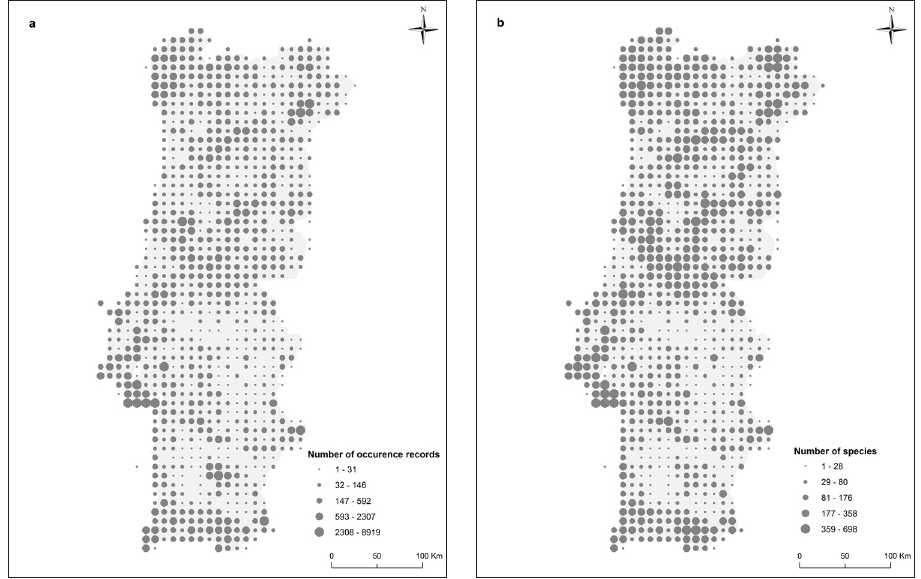
Figure 4. Number of occurrences ( a ) and species ( b ) recorded in Portugal mainland per 10×10 km square. The dataset used in this analysis includes a total of 253,310 records. Numbers were classified with geometrical intervals. The dots are placed at the centre of WGS84 UTM